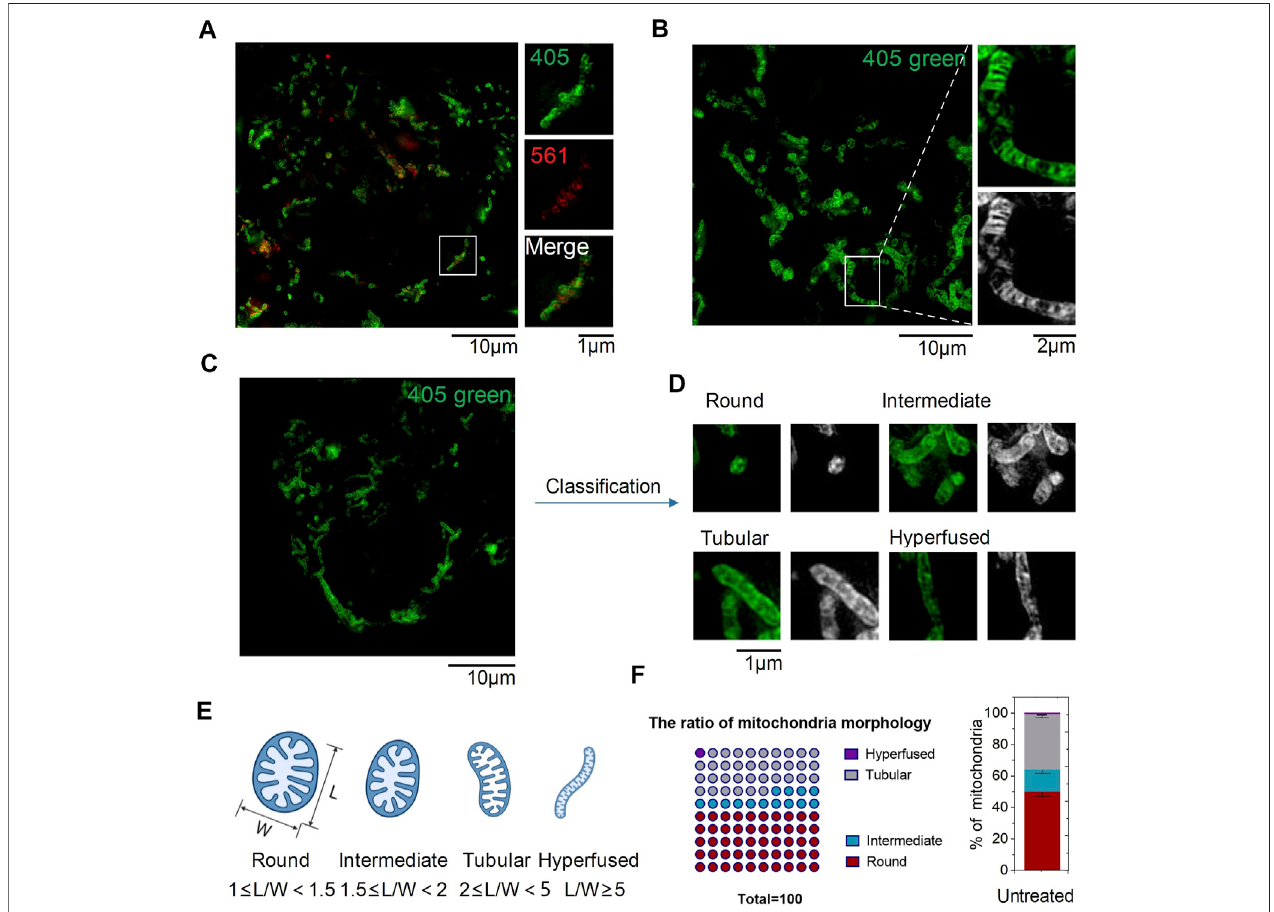
FIGURE2| SIMimagesofCPE punctainHeLacells( λ ex 1=405 nmand λ ex 2=561 nm). (A) SIMimage ofcellslabeled withCPE (10 µM)for1 h. (B) Mitochondrial crista. (C – E) Mitochondrial morphology of distribution parameters of L/W . (F) Ratio of mitochondrial morphology.